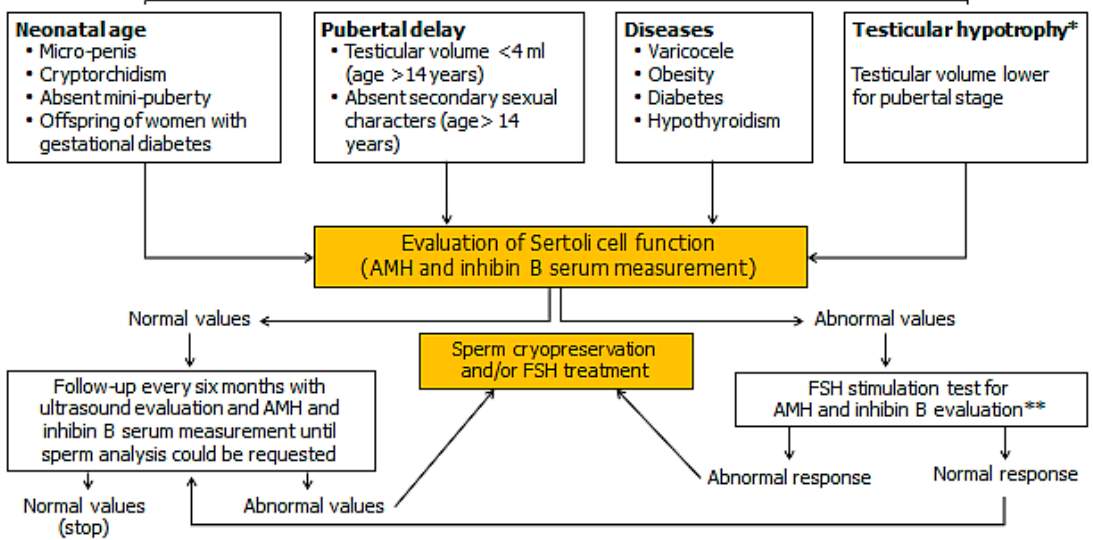
Figure 2. Flowchart proposed to help identify early testicular primary testicular tubulopathy in prepubertal and transitional age. * [42]; ** [15].